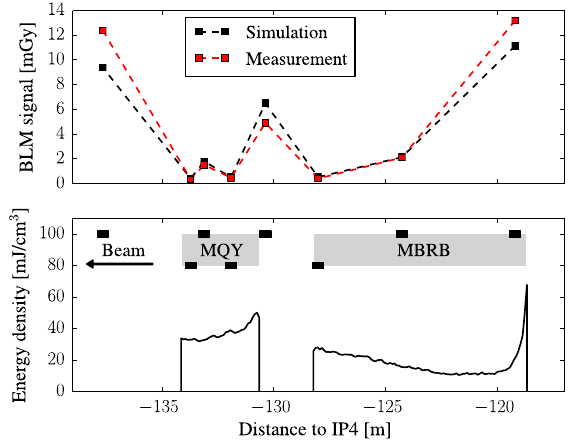
FIG. 10. Up: Comparison of integrated BLM signal accumu- lated during the wire-scanner quench test and simulated with FLUKA. Down: FLUKA simulated peak energy density depos- ited in the coils over the entire event. Gray boxes indicate magnet cold masses, black boxes indicate the locations of BLMs.